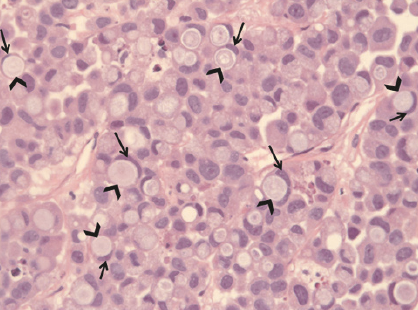
Figure 3: The histopathological examination of the liver-biopsy specimens showed a poorly differentiated, diffusely infiltrating signet ring cell carcinoma (SRCC), grade 3. SRCC consists of signet ring cells, containing abundant intracytoplasmic mucin (arrow- heads) pushing the nucleus (arrows) to the periphery. Hematoxylin- eosin stain, x40